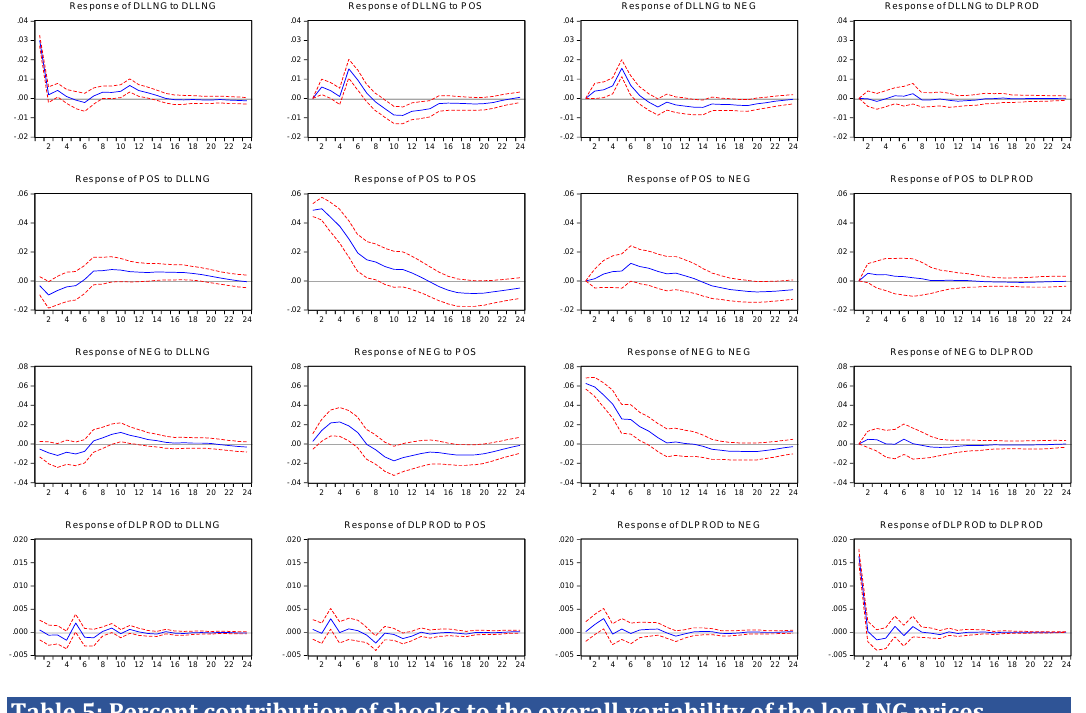
Table 5: Percent contribution of shocks to the overall variability of the log LNG prices Horizon